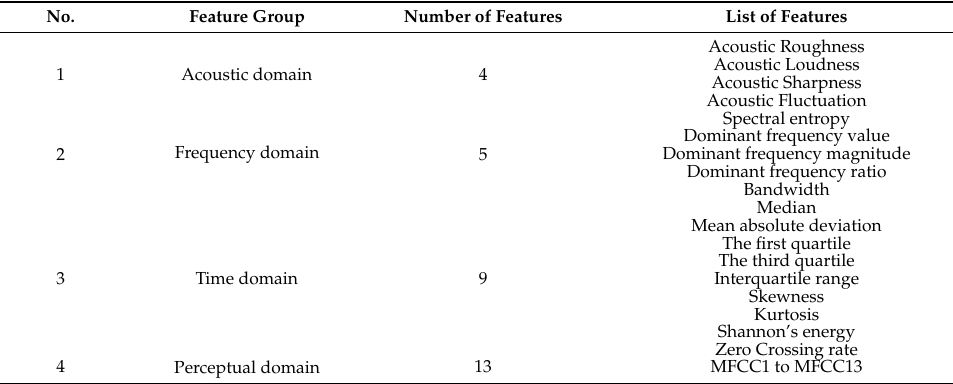
Table 2. Summary of features used in this study, grouped into four major parts as time domain, frequency domain, perceptual domain, and acoustic